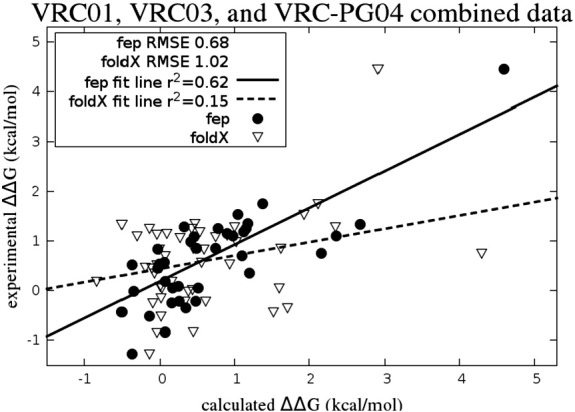
Combined set of mutations for VRC01, VRC03, and VRC-PG04 (filled circles) with FEP/REST compared with the results of the empirical foldX program (open squares).